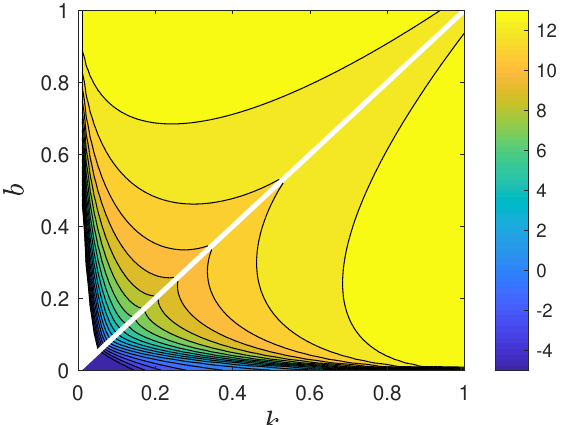
Figure 2. Exact ψ m versus k and b in the lower right triangle, and approximate ψ m using Equation (74) above the diagonal (mirrored, to allow for a simple comparison with the exact ψ m ). All analytic results for the SIRV functions in terms of reduced time τ are basically exact for those k and b for which ψ m is well described by its approximant. The white space in the lower left corner is the regime of b < b c , where the SIRV model results are captured by linearly interpolating between the SIR model and the SIRV model evaluated at the critical b = b c